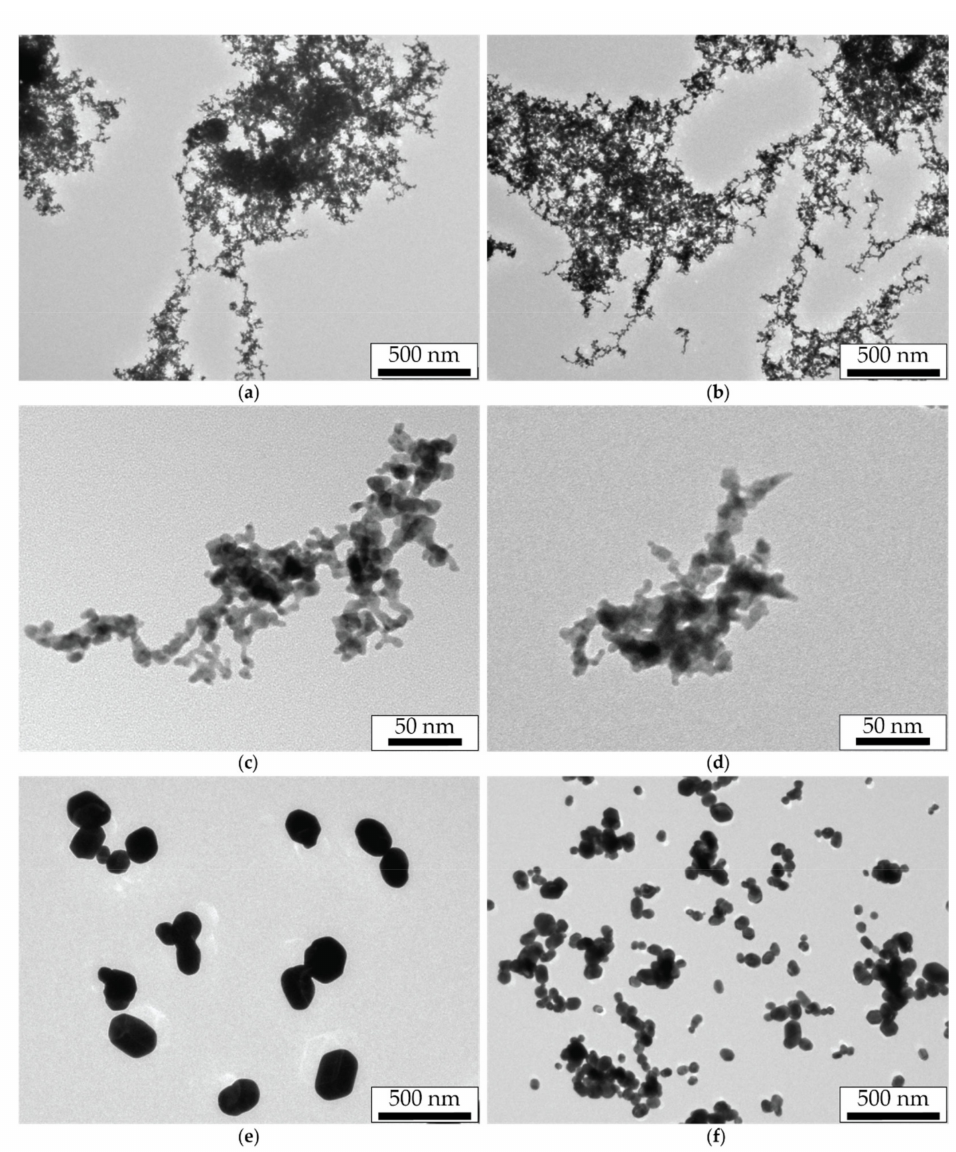
Figure 2. TEM images of ( a – d ) gold NPs agglomerates and ( e , f ) thermally modified spherical NPs obtained at the flow rates of ( a , c , e ) 50 mL/min and ( b , d , f ) 400